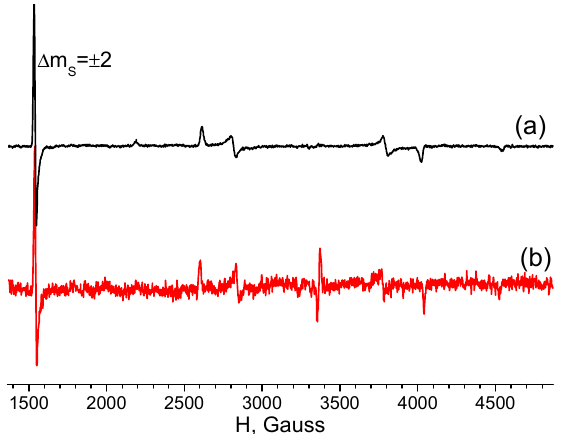
Figure 3. The ESR spectra recorded during continuous irradiation of toluene solutions of Phz1 ( a ) and Phz2 ( b ). The background spectra recorded for the same samples in the absence of light irradiation were